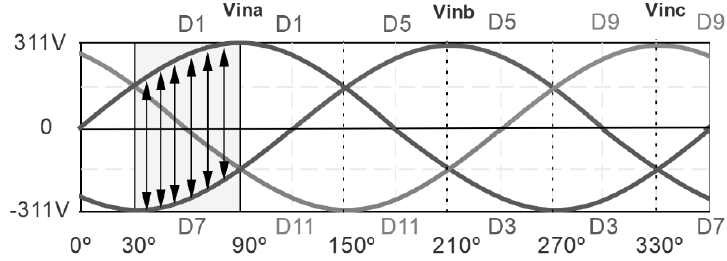
Figure 5. Interaction analysis interval.